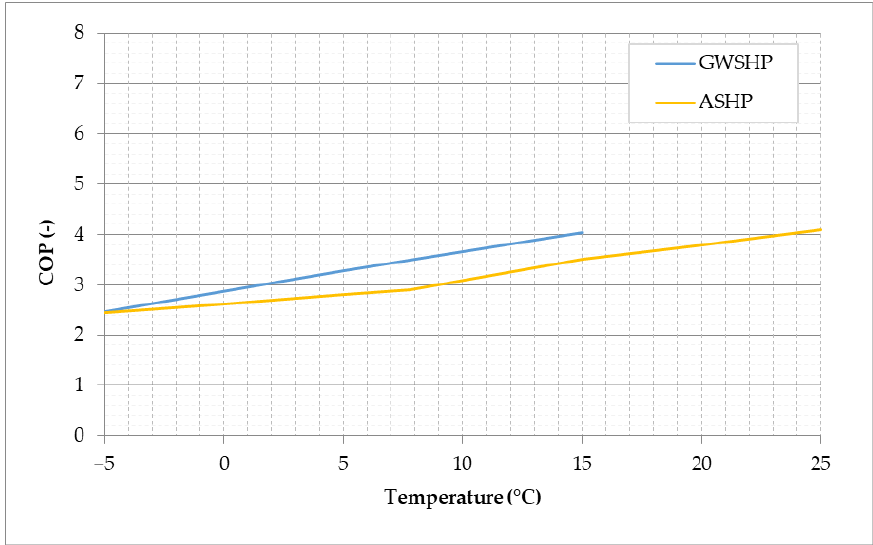
Figure 4. COP values of the heat pumps as a function of the temperature of the heat source based on [42,43].